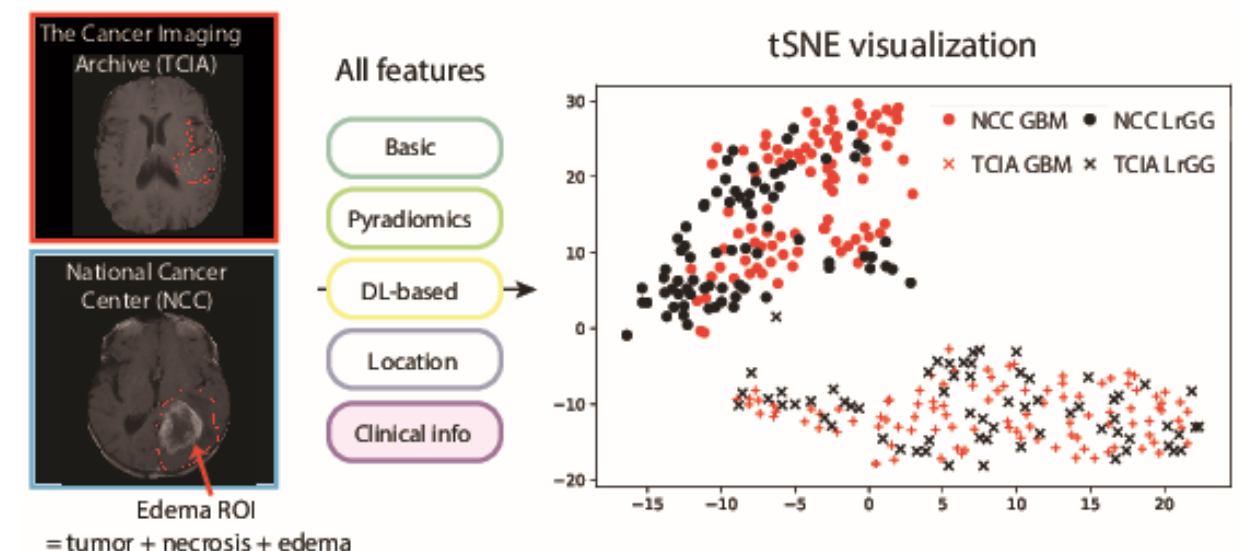
Figure 2. t-SNE visualization of all data from the TCIA and NCC datasets. Red and black colors depict GBM and LrGG patients, respectively, while crosses and circles indicate patients from TCIA and NCC datasets, respectively. The plots were based on image features calculated from MRI brain images and edema ROI annotation information and clinical features.